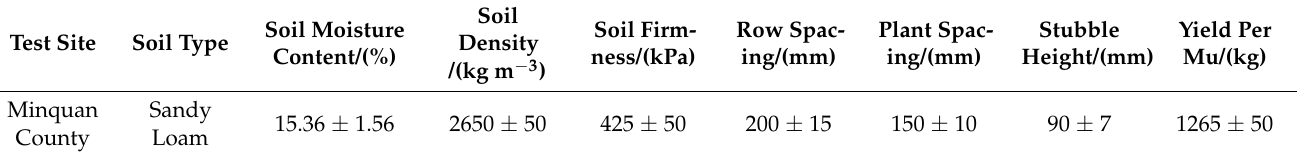
Table 4. Test conditions at field experiment